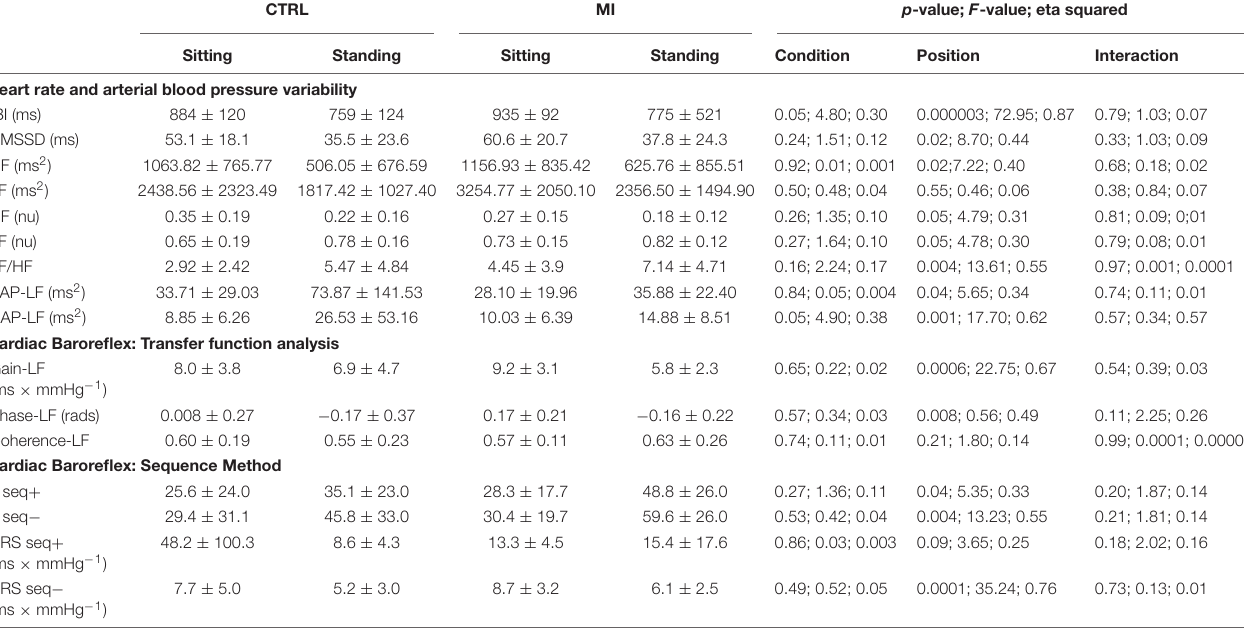
TABLE 4 | Autonomic nervous system responses during CTRL and MI sessions. CTRL MI p -value; F -value; eta squared Sitting Standing Sitting Standing Condition Position Interaction Heart rate and arterial blood pressure variability